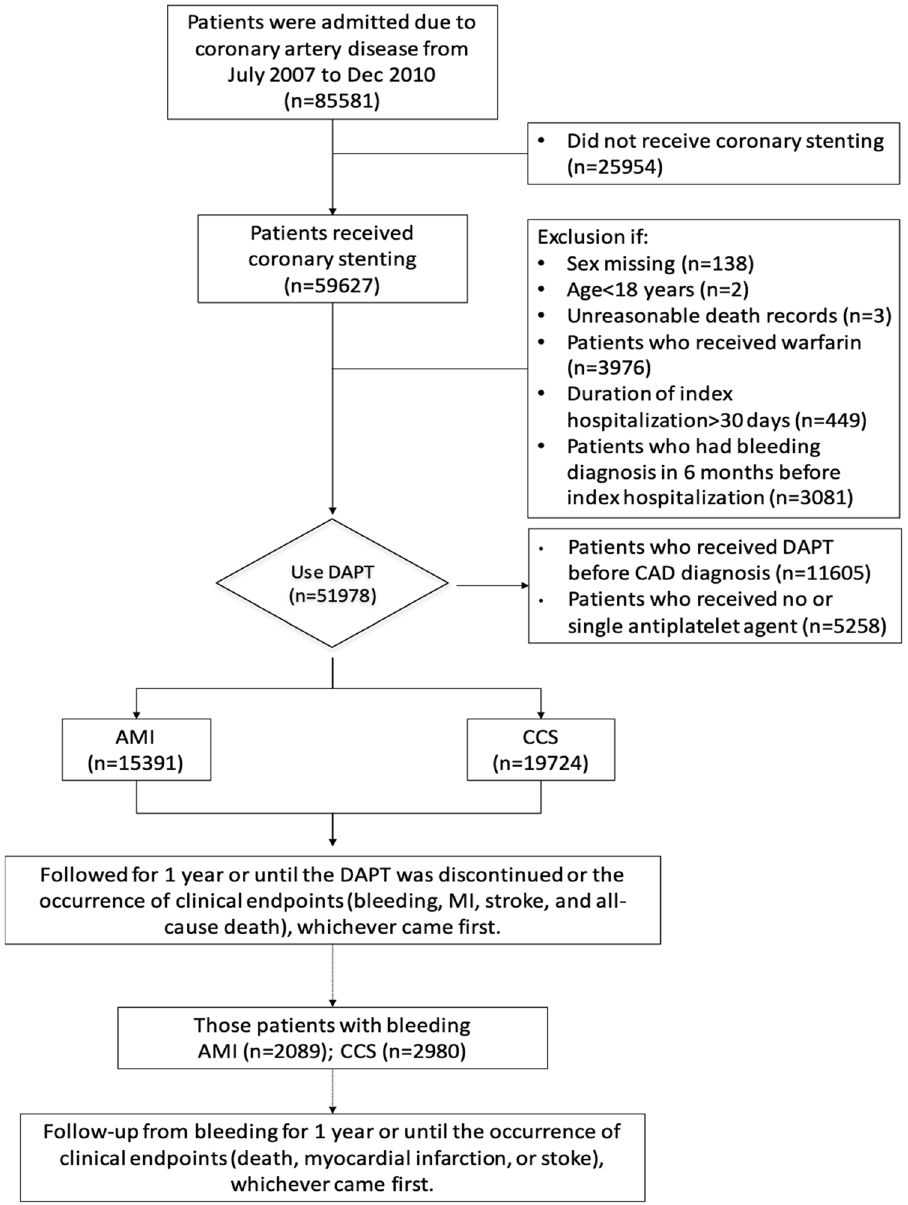
Figure 1. Patient enrollment. AMI, acute myocardial infarction; CAD, coronary artery disease; CCS, chronic coronary syndrome; DAPT, dual antiplatelet